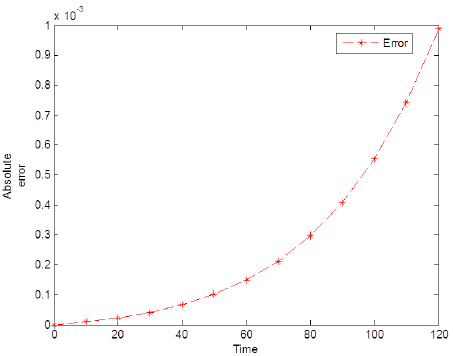
Figure 1. Errors generated via the scheme (40)